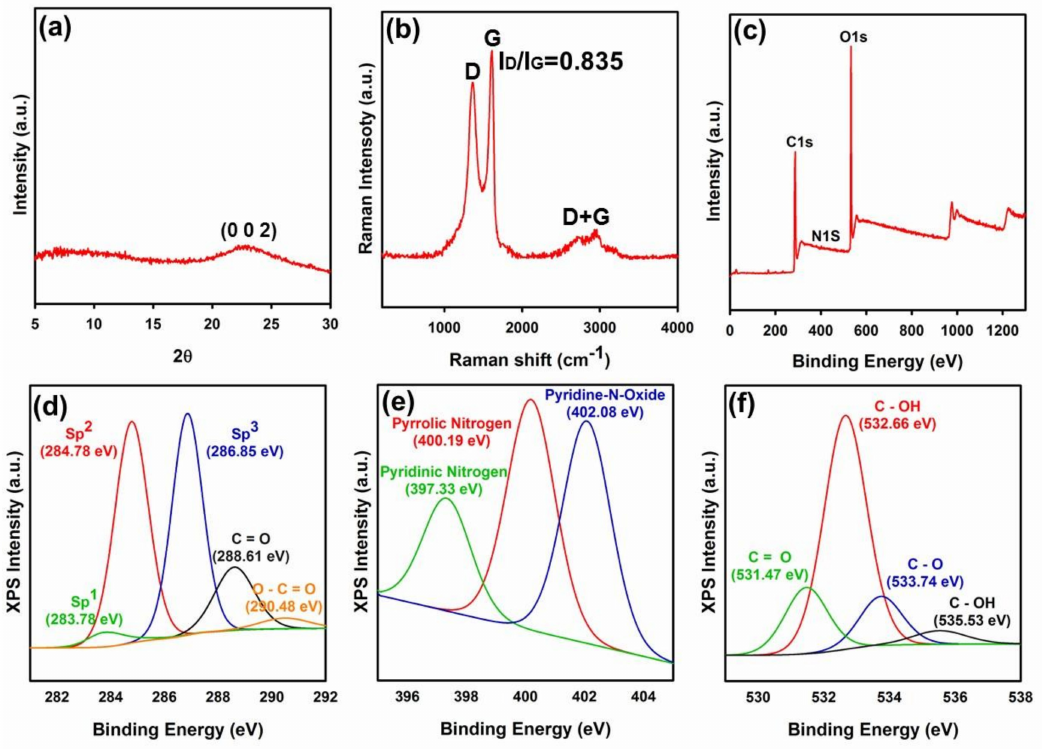
Figure 1. ( a ) XRD result of the developed GO, ( b ) micro Raman spectroscopy of GO, ( c ) XPS elemental analysis of GO; De-convolution of GO XPS peaks ( d ) C1s, ( e ) N1s, and ( f ) O1s into diverse